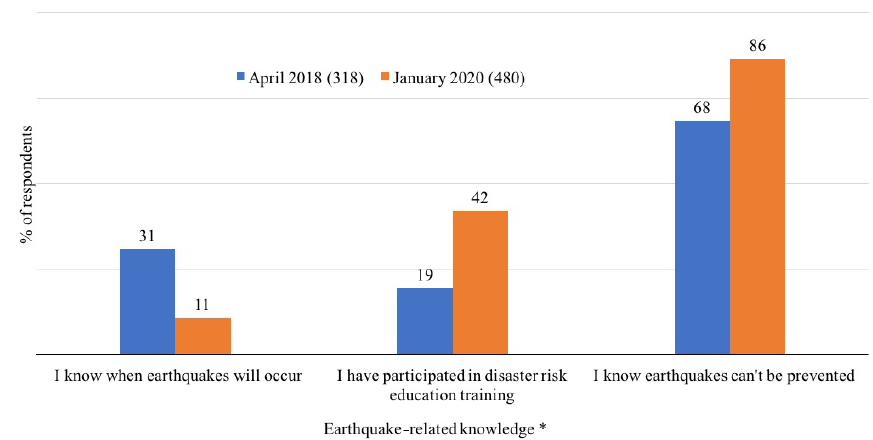
Figure 7. Students’ personal knowledge about earthquakes (Q13), before and after the initiation of our education program. Note: ∗ – Multiple answers were possible.